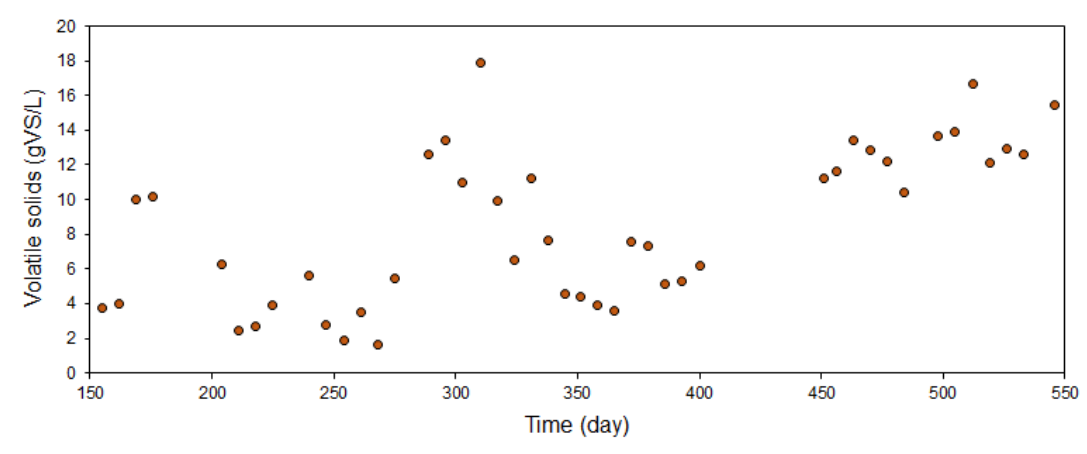
Figure 4. Microscopic images of the mixed liquor of the photobioreactors: ( a ) Coccal Cyanobacteria resembling Synechococcus sp. and small filamentous Cyanobacteria, surrounded by green microalgae, ( b ) filamentous Cyanobacteria resembling to Oscillatoria sp. and Leptolyngbya sp. and coccoid Cyanobacteria resembling to Chroococcus sp., Synechococcus sp. and Synechocystis sp., and ( c ) filamentous green microalgae, observed under bright light microscopy during the operation of the